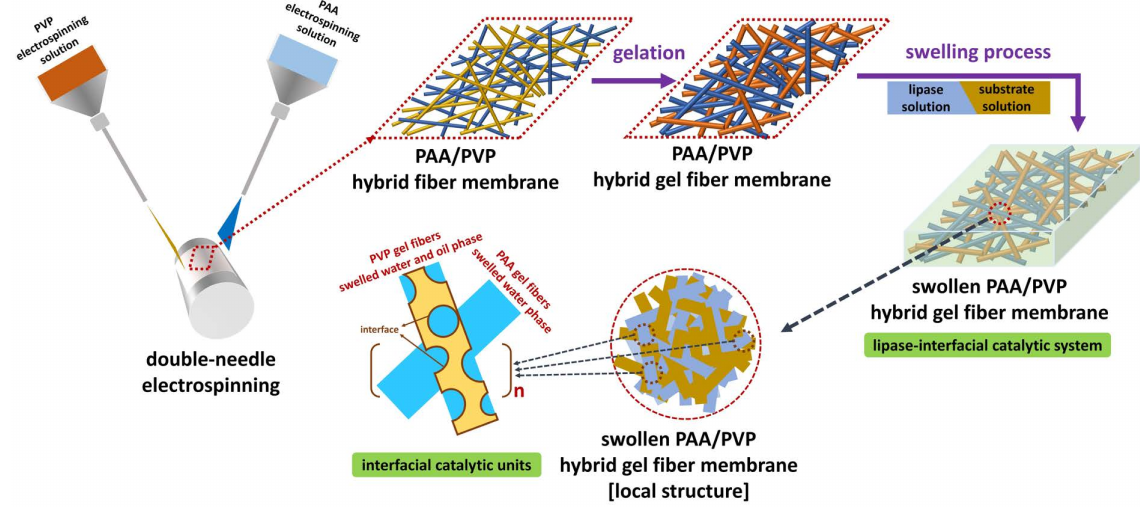
Figure 1. Illustration of the two-step preparation strategy of PAA/PVP hybrid gel fiber membranes based on double-needle electrospinning and gelation and the construction of an interfacial catalytic system for